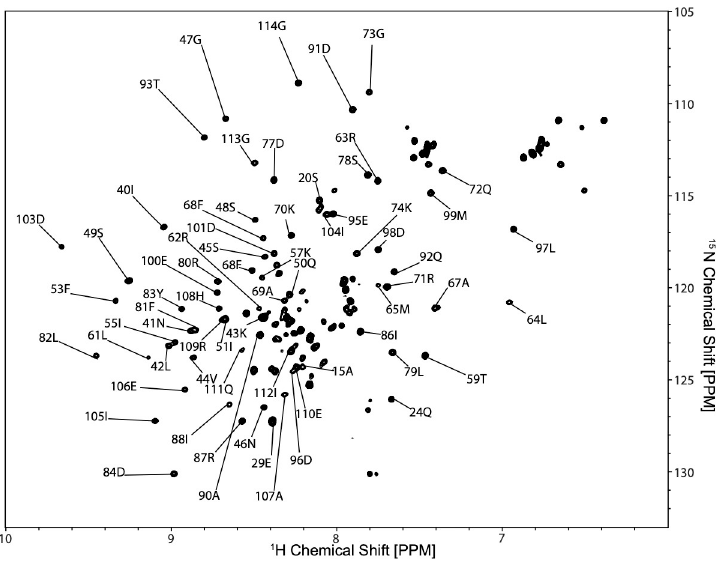
Fig 6. SUMO-G0S2 spectra. 15 NHSQC spectra from nitrogen-labeled SUMO-G0S2, with SUMO assigned resonances.